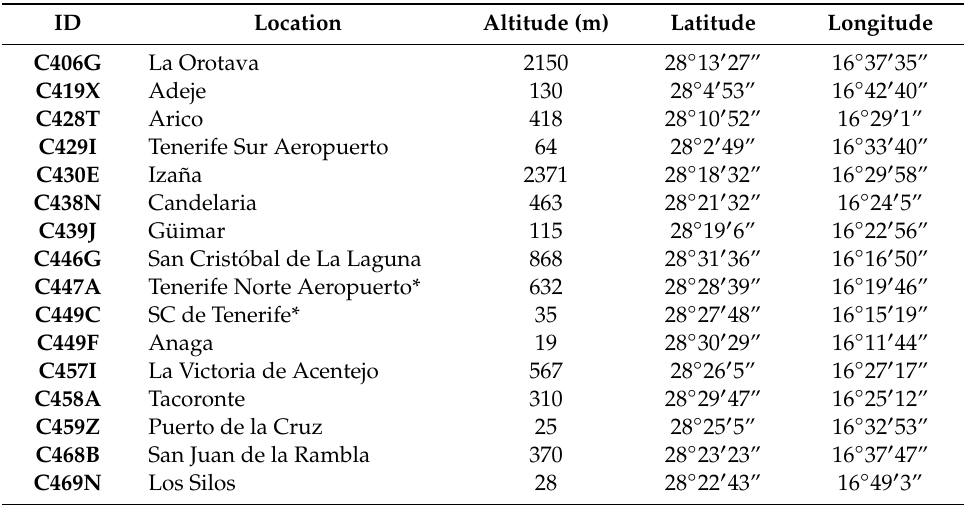
Table 1. Main weather stations on Tenerife Island. The asterisk * identifies the selected Tenerife North Airport and Santa Cruz de Tenerife weather stations.